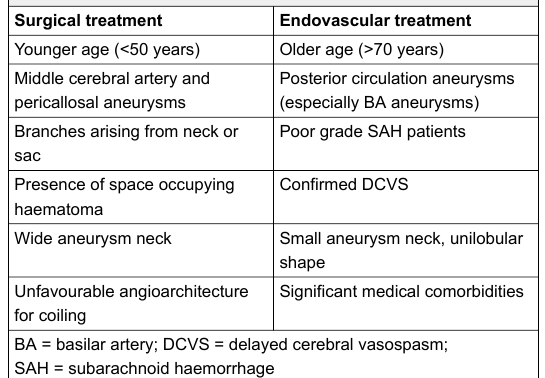
Table 4: Summary of factors either in favour of surgical or endovascular intervention. Surgical treatment